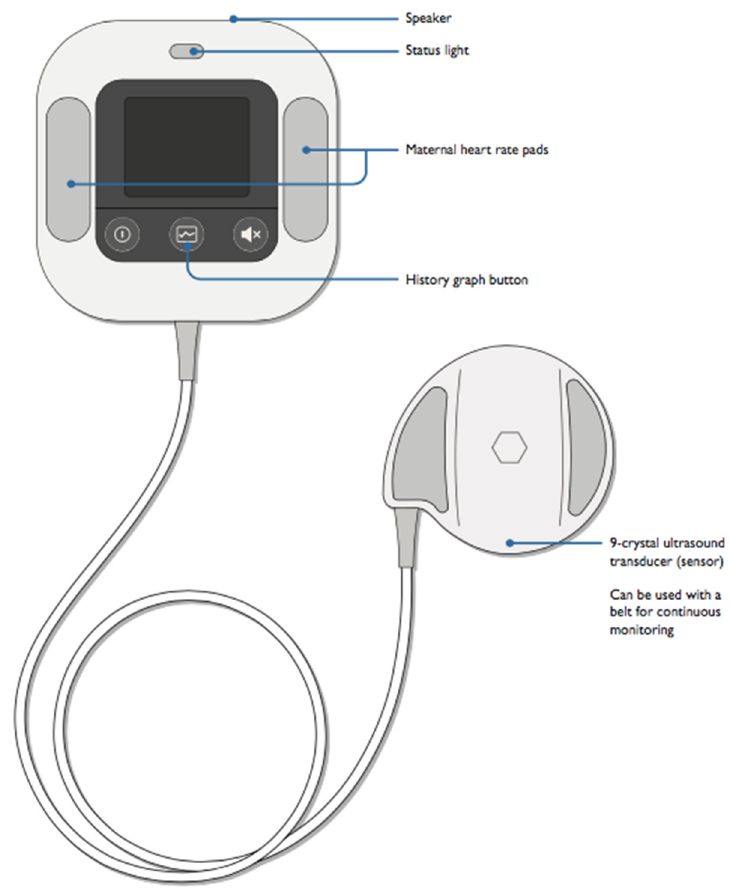
Figure A1. The Fetal Heart Rate (FHR) monitor, Moyo (Laerdal Global Health).